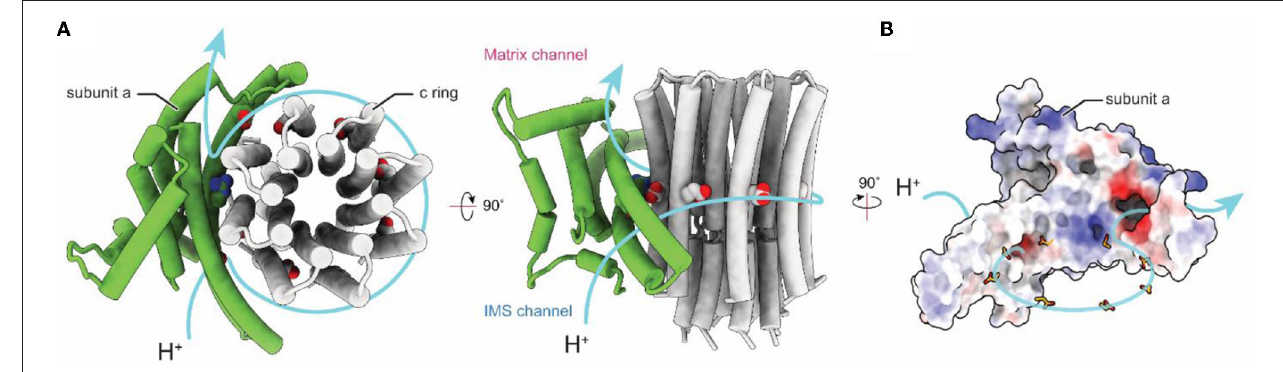
FIGURE 3 | Proton translocation in ATP synthase. (A) Proton path (blue arrow) through the interface between the a and c subunits of the F O region of bovine ATP synthase (PDB: 6ZPO) (Spikes et al., 2020). The conserved arginine in subunit a and acidic residues in the c ring are shown as space filling models. (B) Electrostatic surface of bovine subunit a, with positively and negatively charged surfaces colored blue and red, respectively.